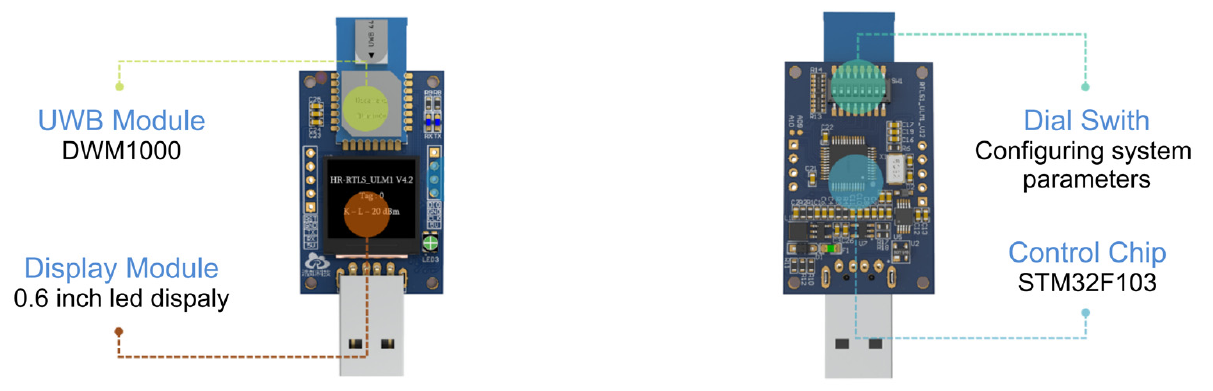
Figure 4. Hardware architecture of the positioning module.